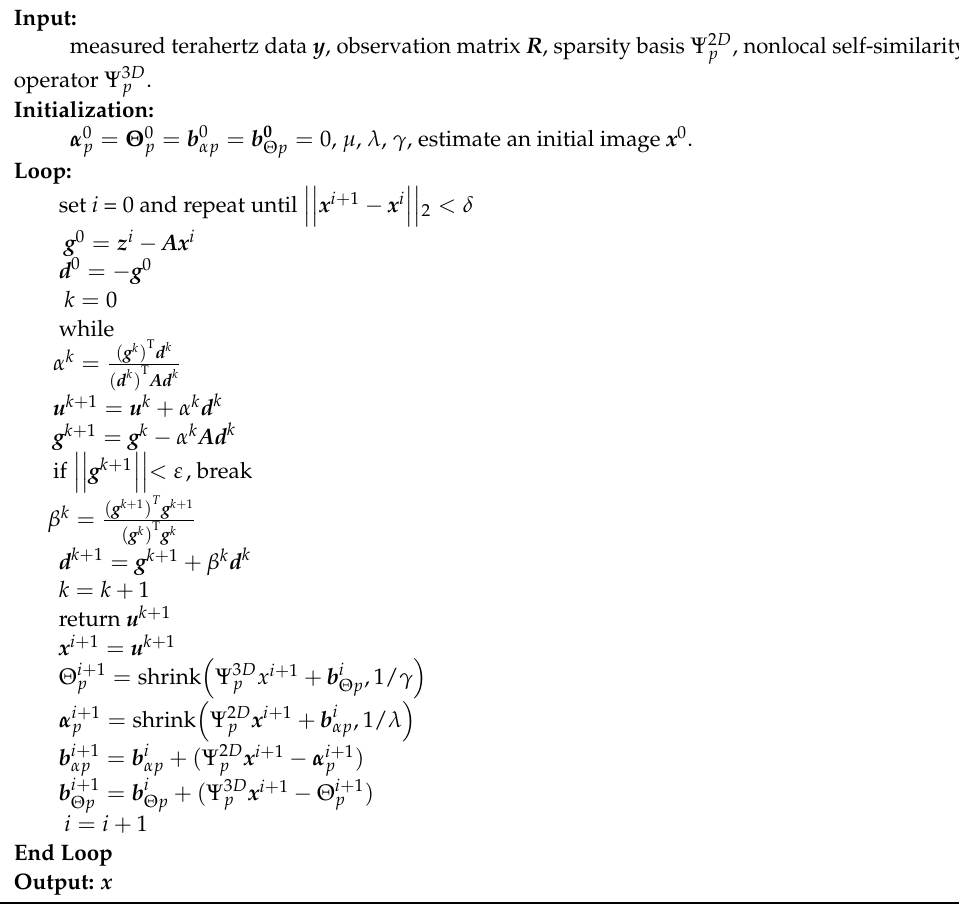
Algorithm 1 The proposed algorithm by combining group sparsity and nonlocal